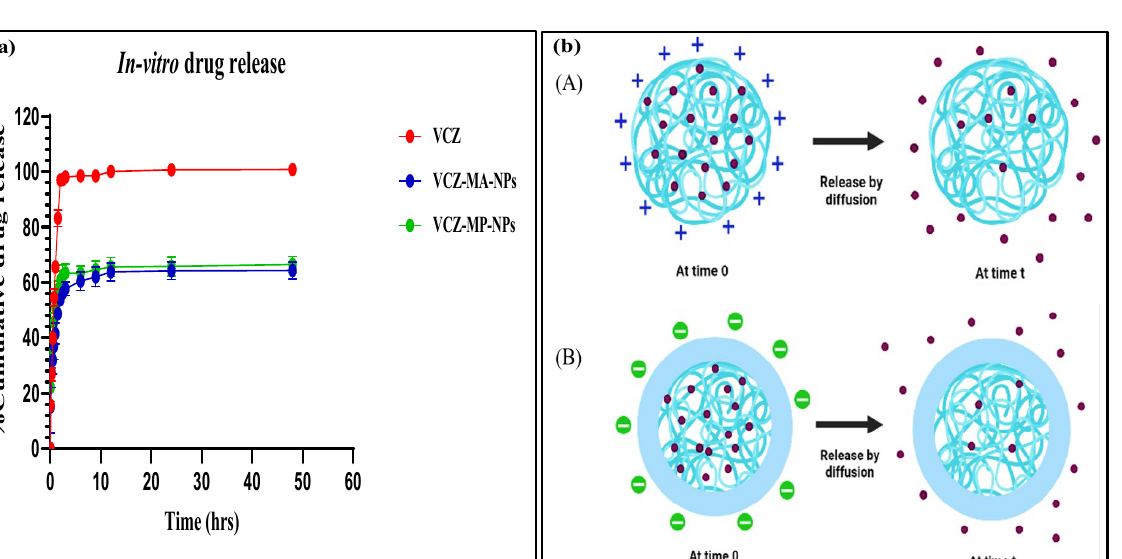
Figure 8. Physical stability of VCZ-MA-NPs (Green Box) and VCZ-MP-NPs (Pink Box) at three different temperatures (4°C, 25°C, and 40°C). No significant changes were observed in terms of color change, turbidity, or drug precipitation during the one month stability study.